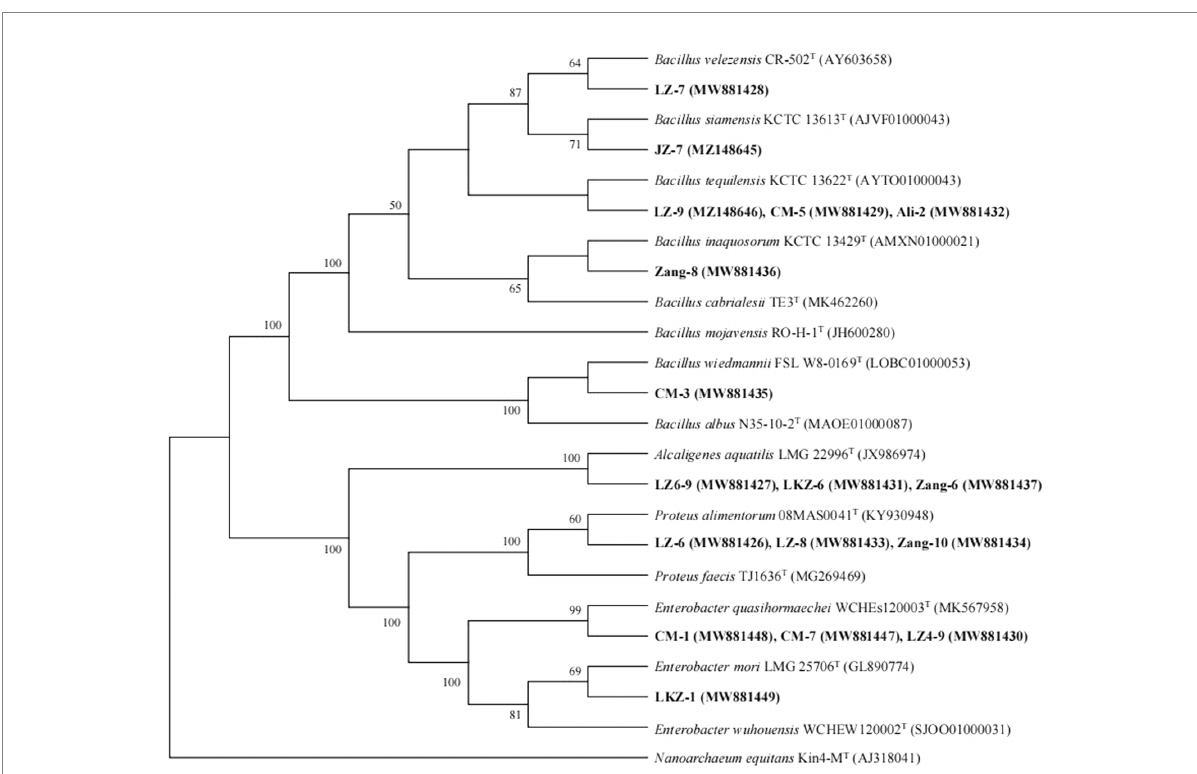
FIGURE 3 Relationships between the representative isolates and reference strains based on 16S rRNA gene (~1,500 bp) phylogenetic analysis. Nanoarchaeum equitans Kin4-M T (AJ318041) was used as an outgroup. Sequences from this study are in bold. Bootstrap values over 50% are shown on the branching